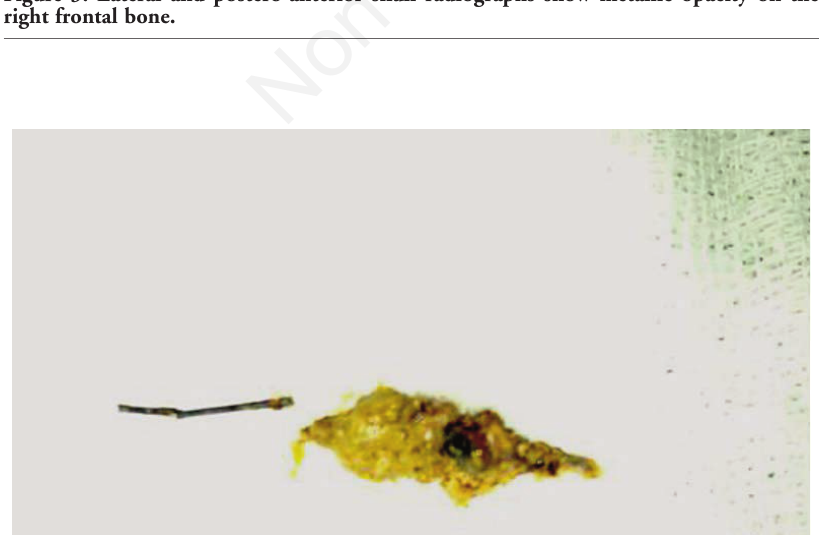
Figure 4. Photograph shows surgically removed needle and gliotic brain parenchyma around